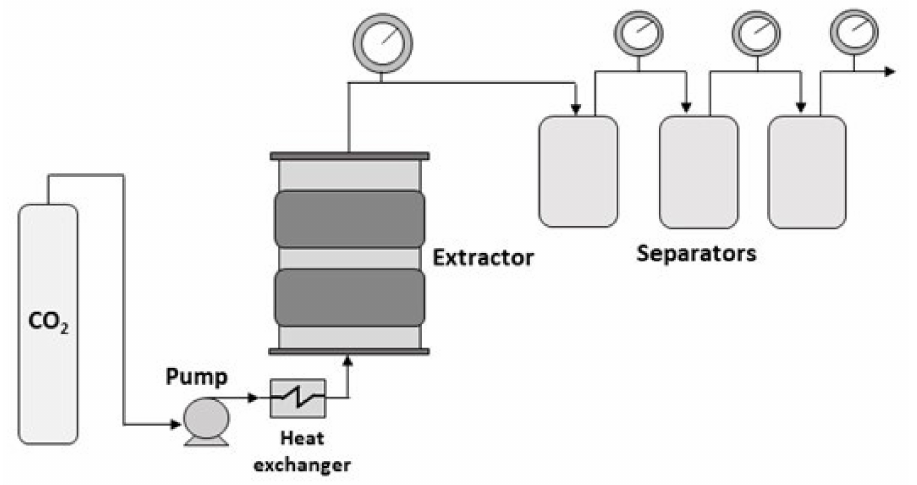
Figure 4. Sketch of the SFE